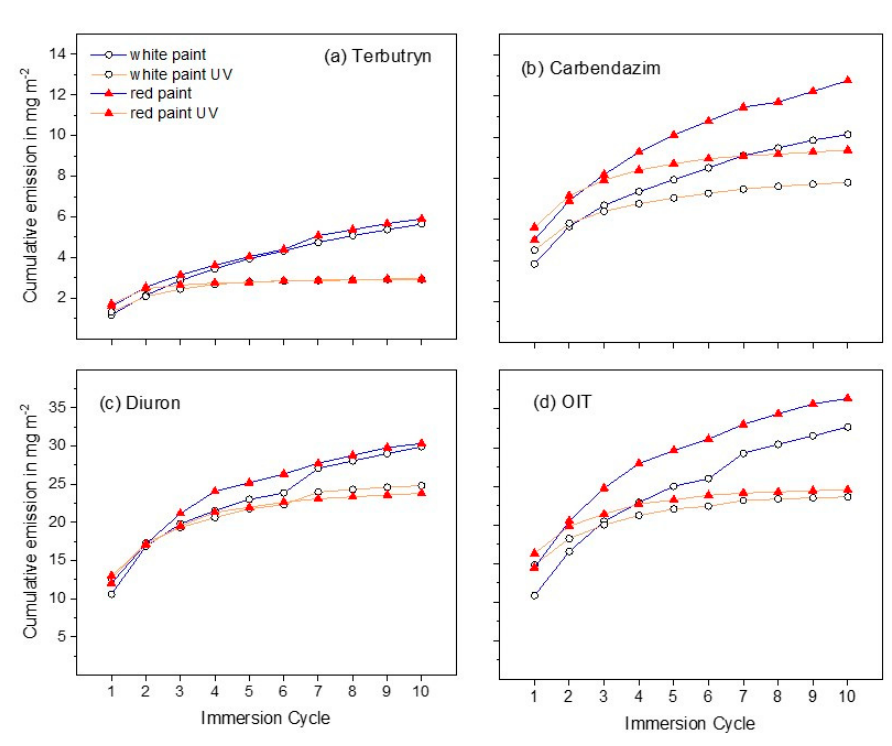
Figure 2. Cumulative emission curves for active substances from paint layers that were exposed either solely to water contact according to the immersion cycles as defined in EN 16105 [15] or to water contact combined with UV radiation. Each data point in the graphs represents a single experiment without